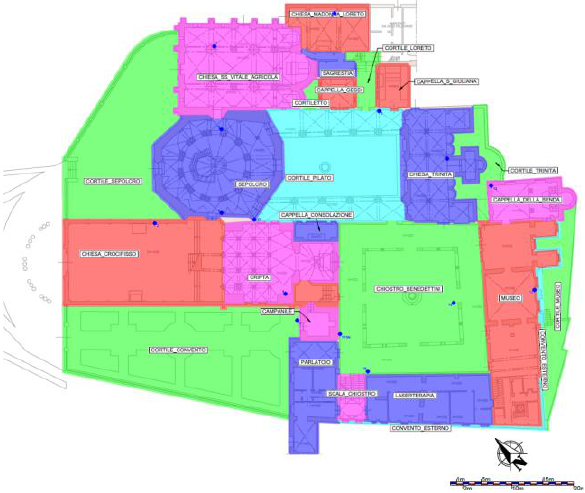
Figure 9. Creating the BIM of St. Stefano Basilica: logical decomposition of the monument in several homogeneous spatial environments, each one colored by different colors. An individual point clouds is obtained for each spatial environment by the splitting the total point